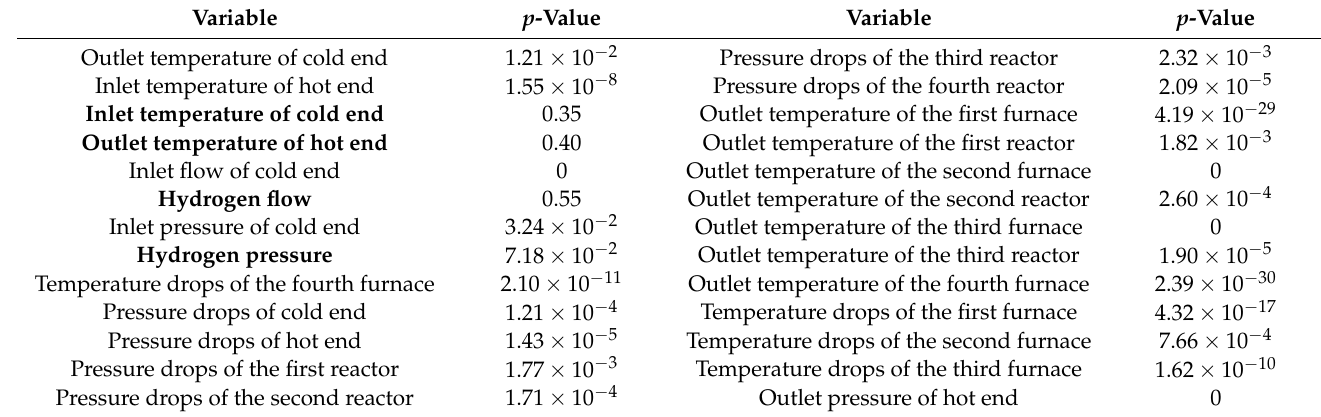
Table 2. Process variables and their unit root test results.